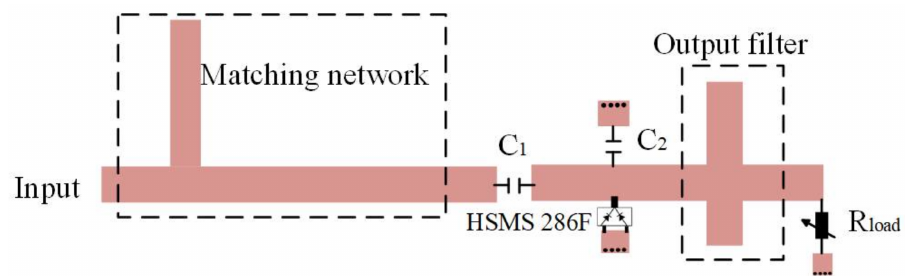
Figure 10. Schematic of rectifying circuit.